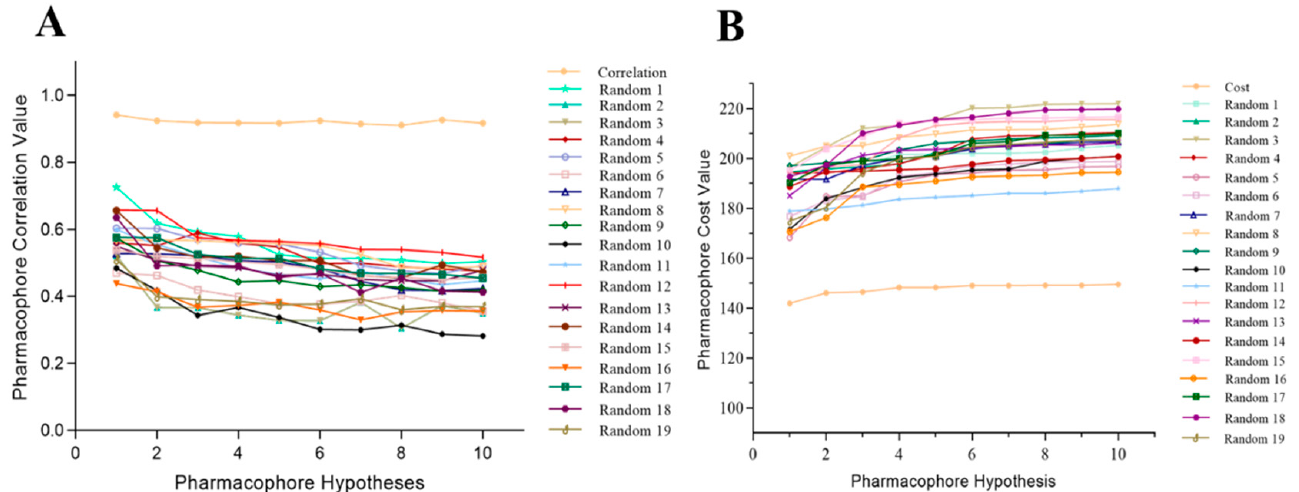
Figure 8. Difference in correlation ( A ) and cost values ( B ) of hypotheses between the selected pharmacophore models: Hypo1 and 19 random spreadsheets.